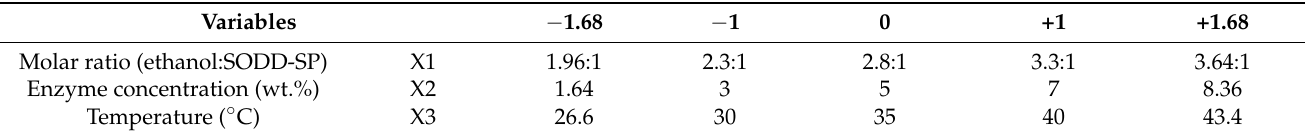
Table 4. Coded values of the input variables for statistical